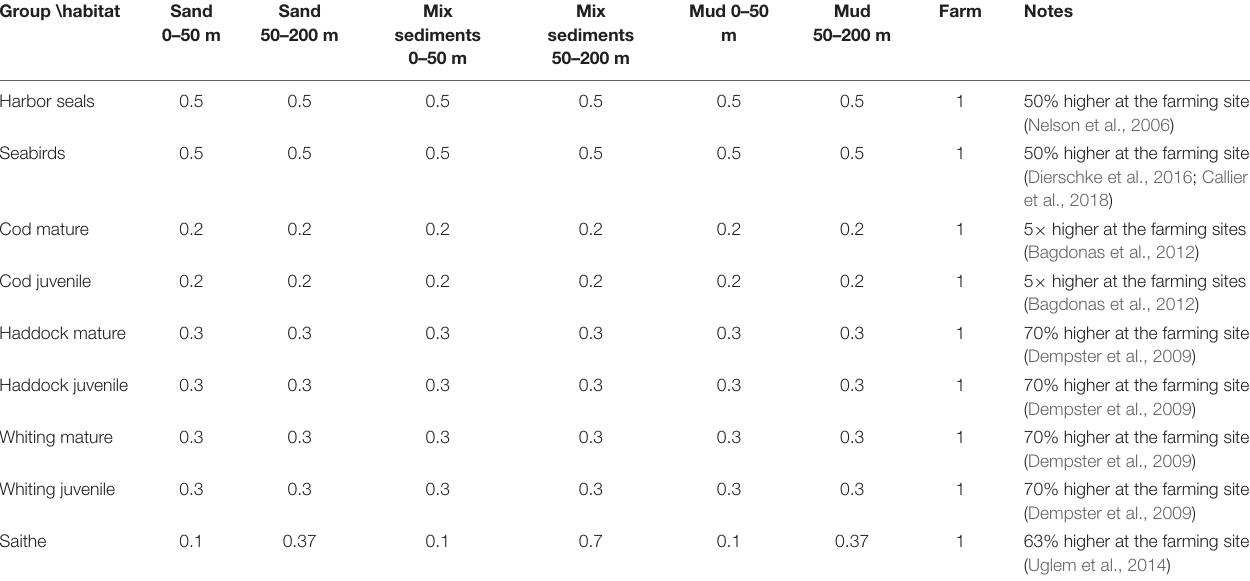
TABLE 2 | Relative changes made for habitat preferences to simulate attraction to the farming site with references